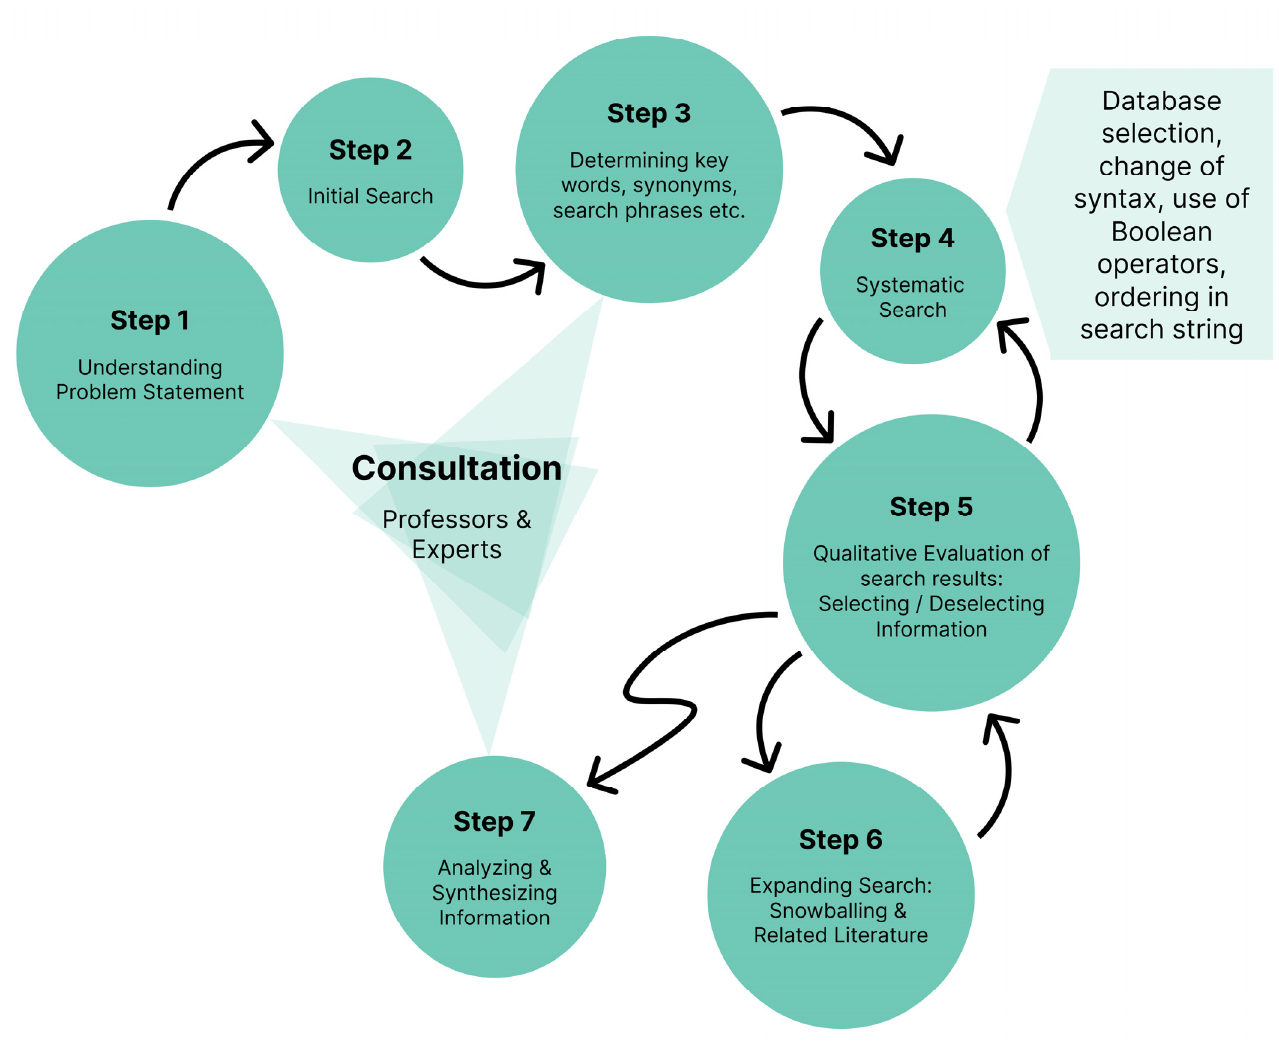
Figure 3. Scoping study methodology. Reprinted with permission from Ref. [28].